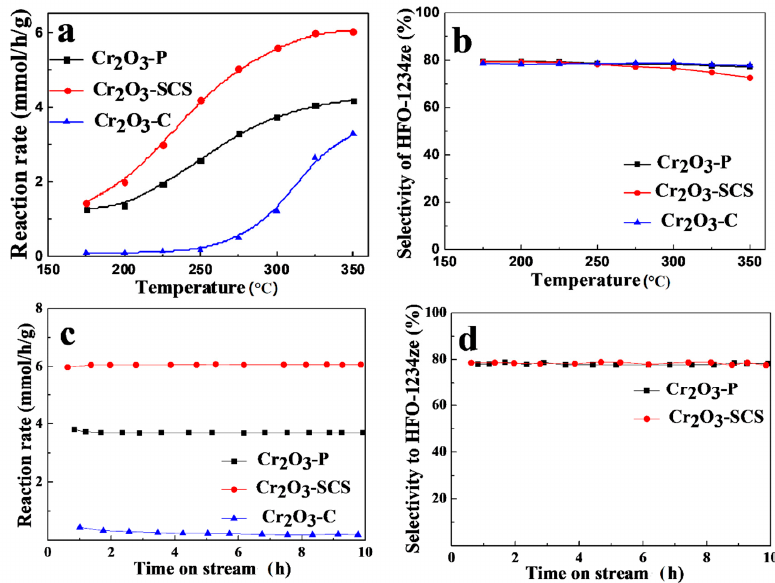
Figure 1. The performance of Cr 2 O 3 catalysts obtained by precipitation method (P), solution combustion synthesis (SCS) and commercial catalyst (C) for the pyrolysis of HFC-245fa. ( a ) The conversion rate of HFC-245fa as a function of reaction temperature and ( b ) the selectivity to HFO-1234ze as a function of reaction temperature. ( c ) The conversion rate of HFC-245fa and ( d ) the selectivity to HFC-1234ze as a function of time on stream at 300 ◦ C. Reaction conditions: 1 atm, N 2 : HFC-245fa of 1:4, GHSV (HFC-245fa) of 150 h − 1